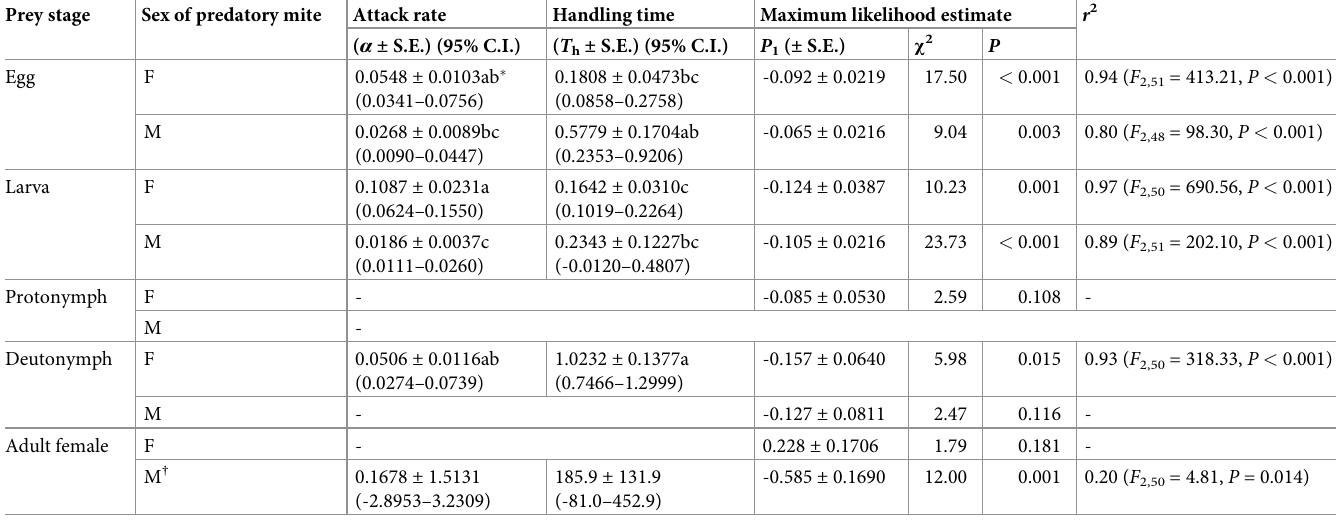
Table 5. Estimates of parameters (mean ± SE) for Amblyseius eharai preying on different stages of Tetranychus urticae for 24 hours: Attack rate, handling time, and P 1 value from the random predation equation and logistic regression.